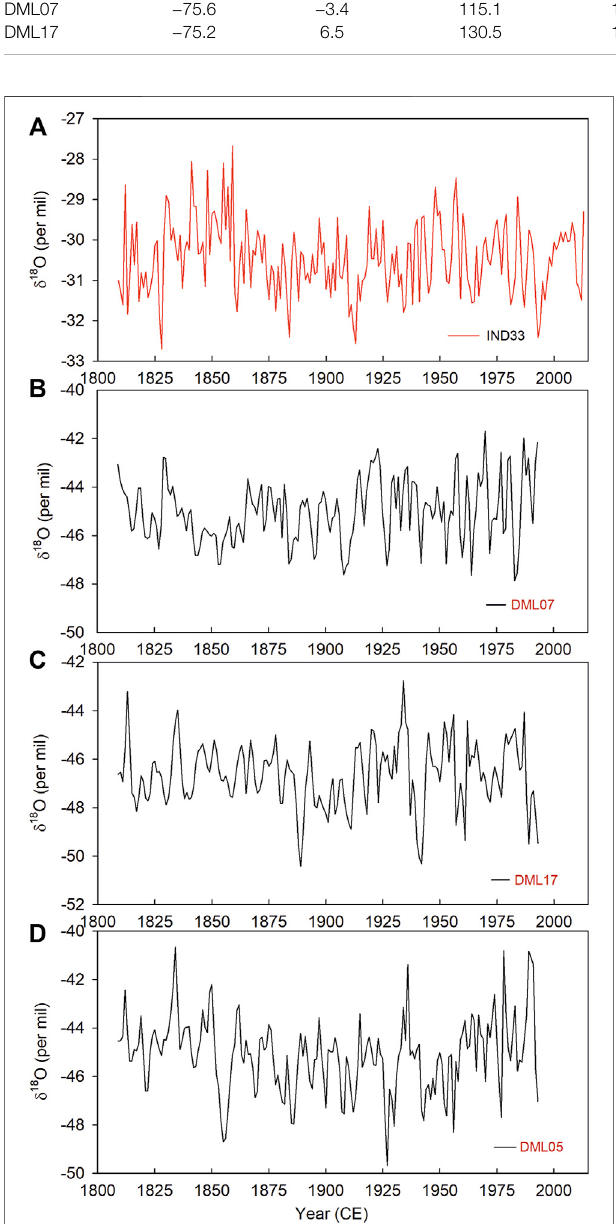
FIGURE 2 | (A) IND33 ice core δ 18 O record (1809 – 2013 CE) is compared with the DML ice core records (B) DML07, (C) DML17, and (D) DML05 of their common time interval (1809 – 2013